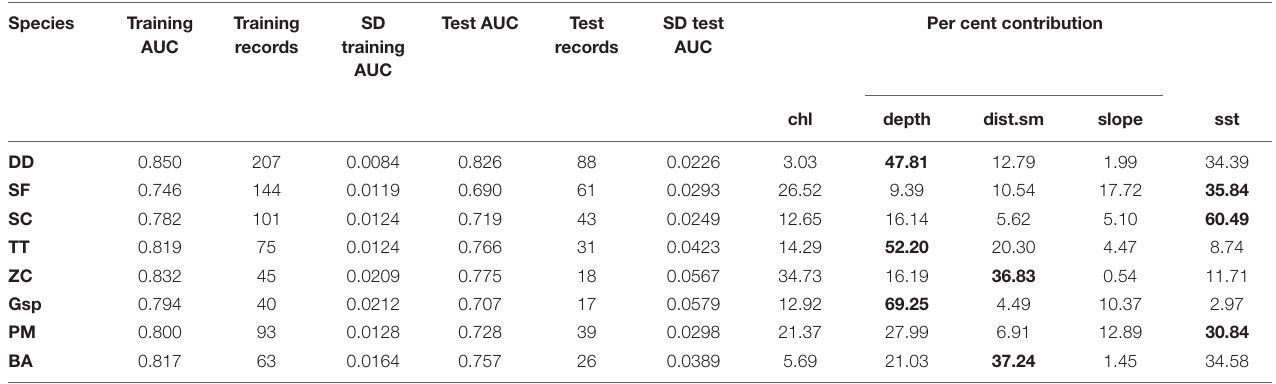
TABLE 2 | Results from the Maxent models developed for the eight most frequently sighted species with the 50 km buffer. Species